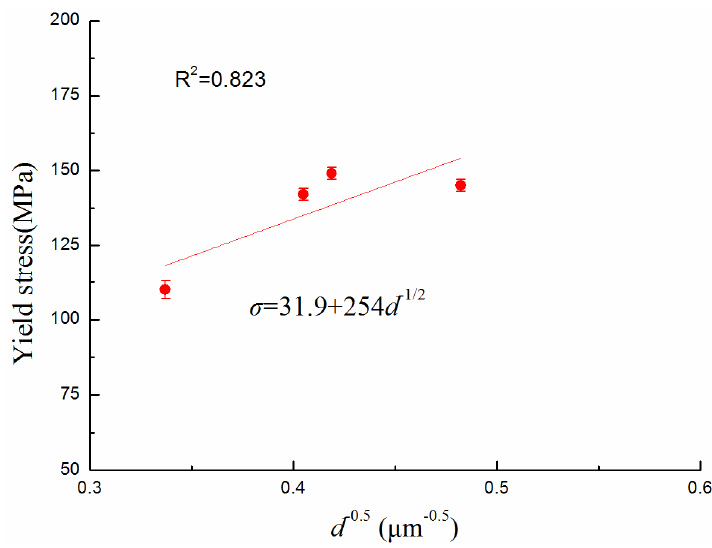
Figure 11. The corresponding Hall–Petch plot.